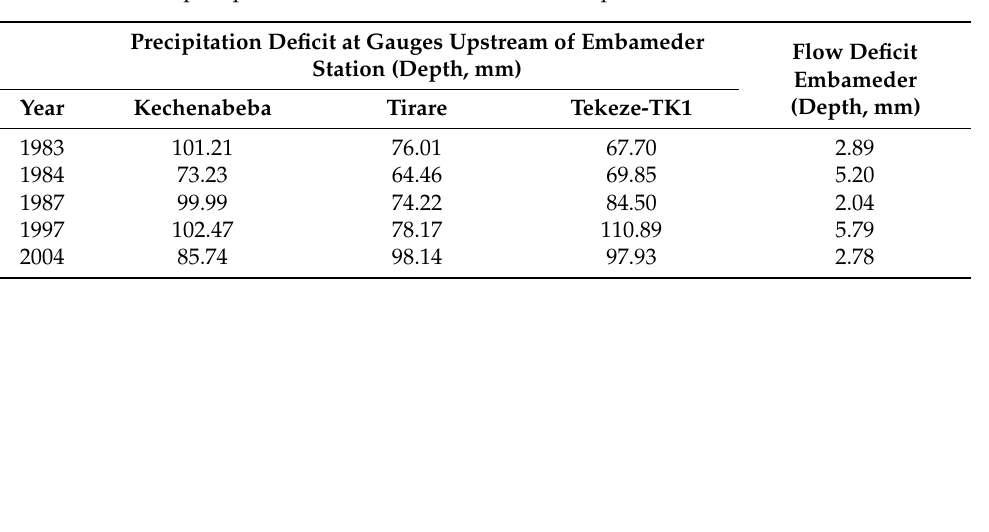
Figure 7. Time series average precipitation deficit at sub-basins upstream of Embameder station and streamflow deficit at Embameder station (1981–2008). Table 2. Years with precipitation and streamflow deficit for September